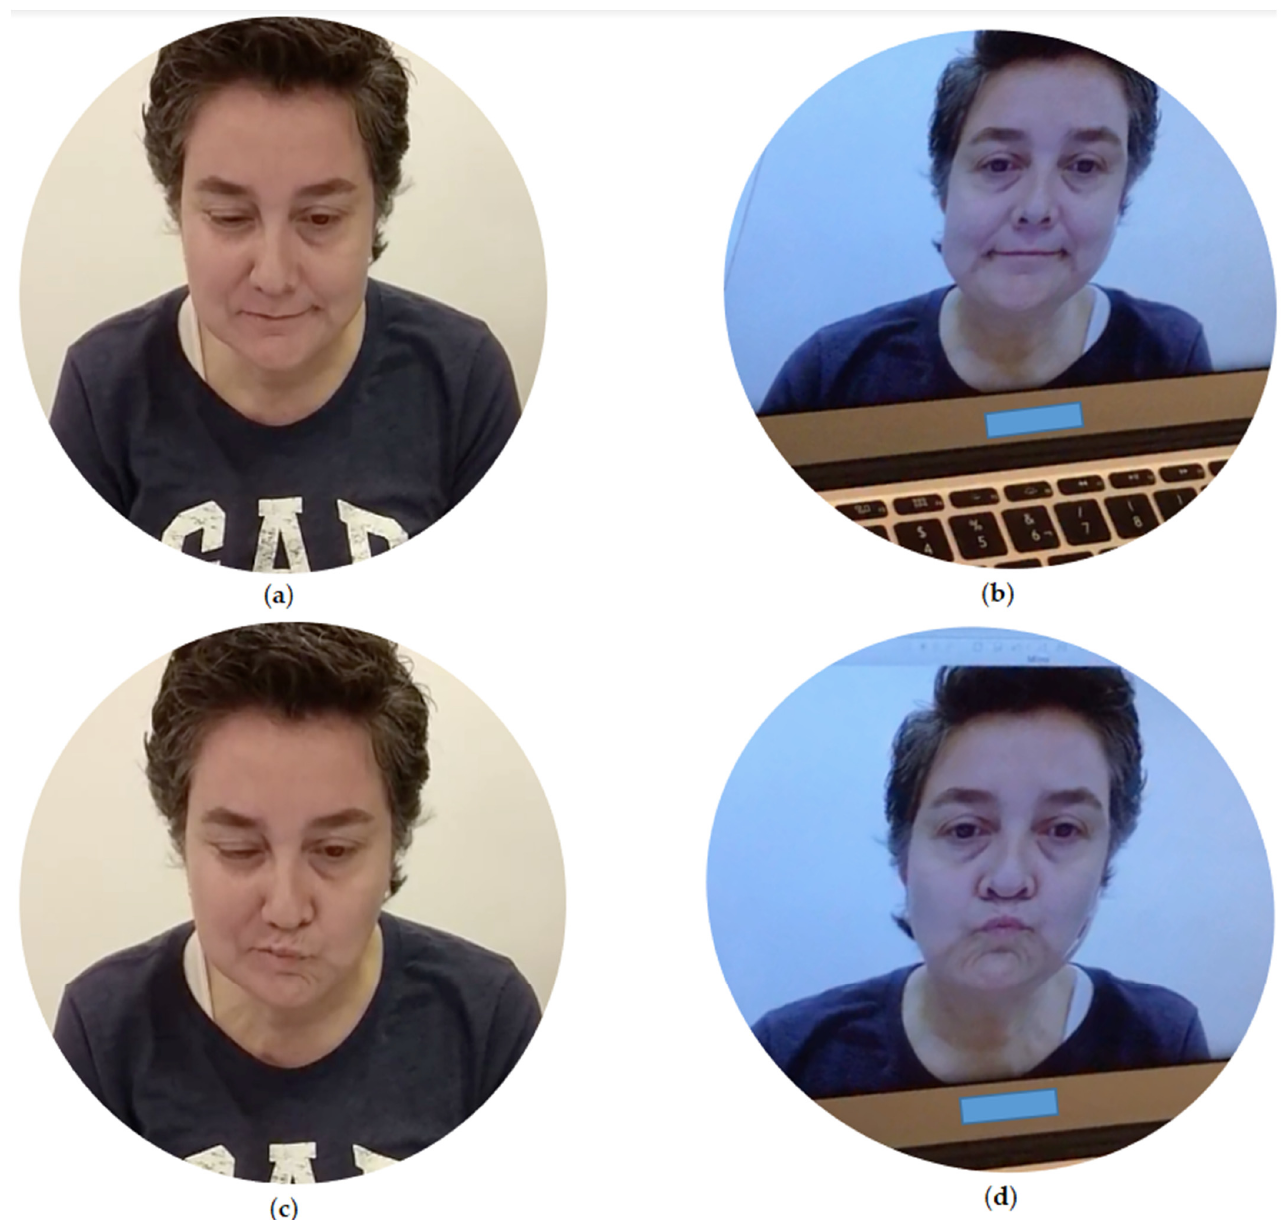
Figure 1. Representation of ( a ) real smile gesture; ( b ) simulated smile gesture by Specular Face at real time; ( c ) real kiss gesture and ( d ) simulated kiss gesture by Specular Face at real time. Table 2. Maximum electromyographic data (millivolts) in patients with facial palsy.